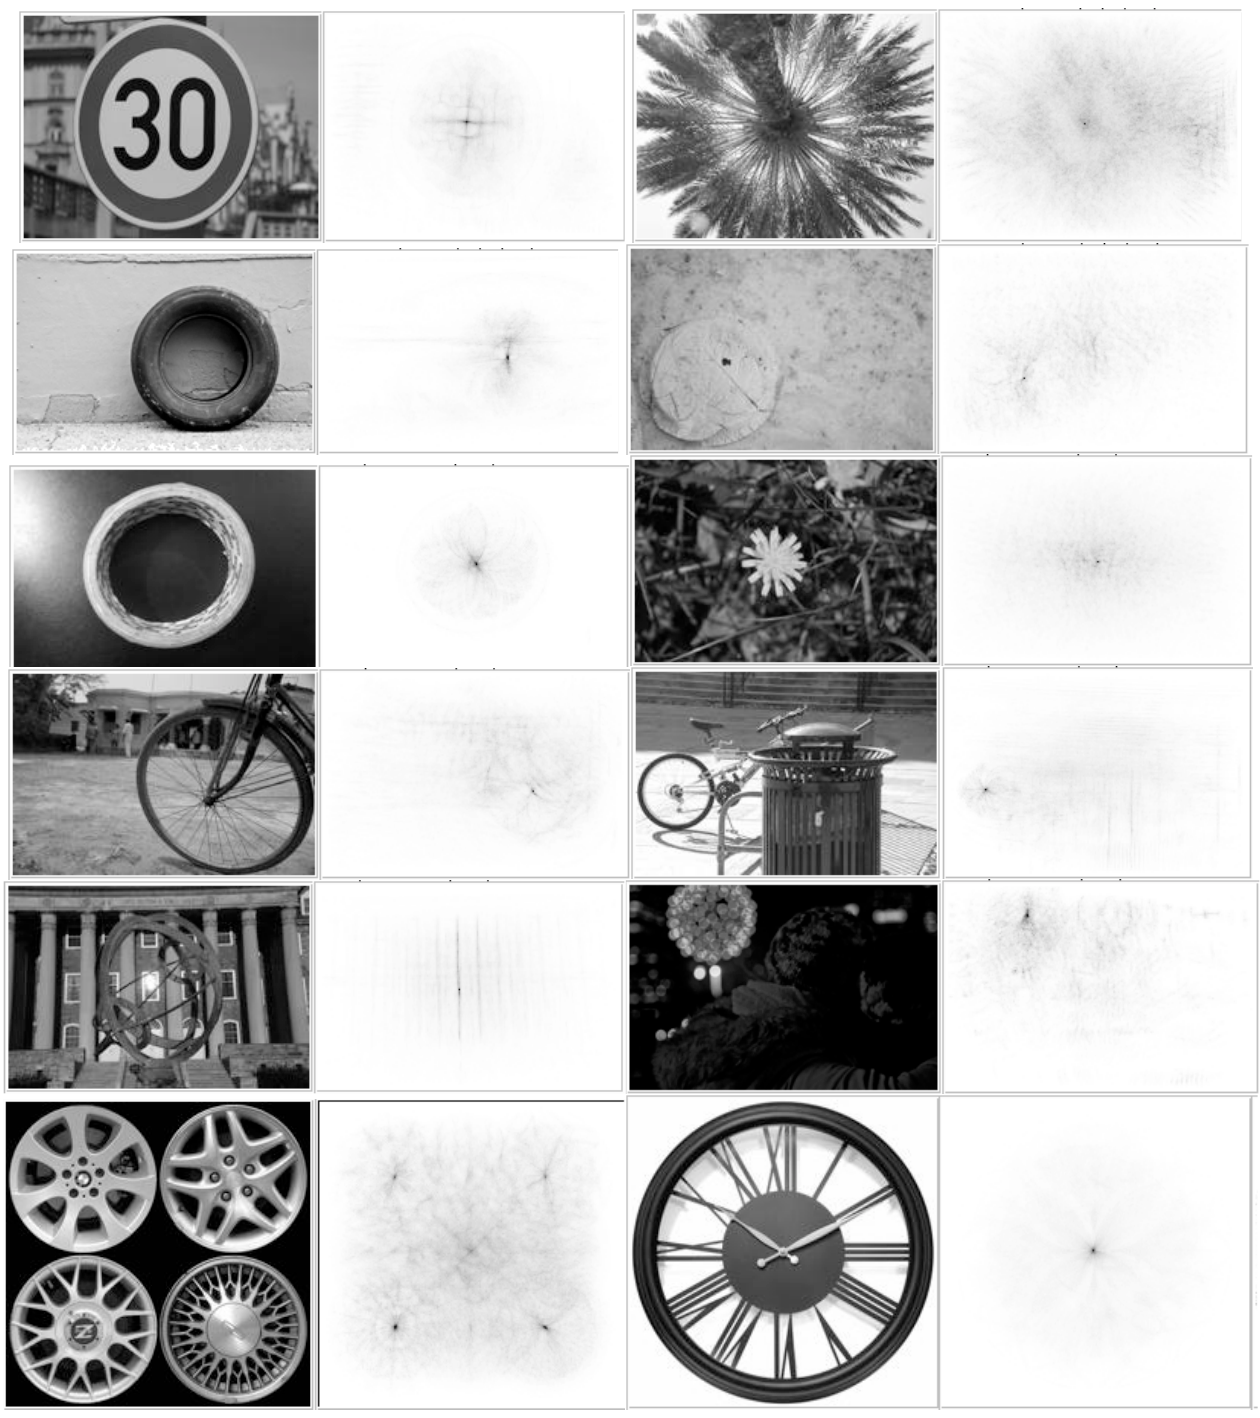
Figure 7 . Original images and their corresponding IGHM symmetry